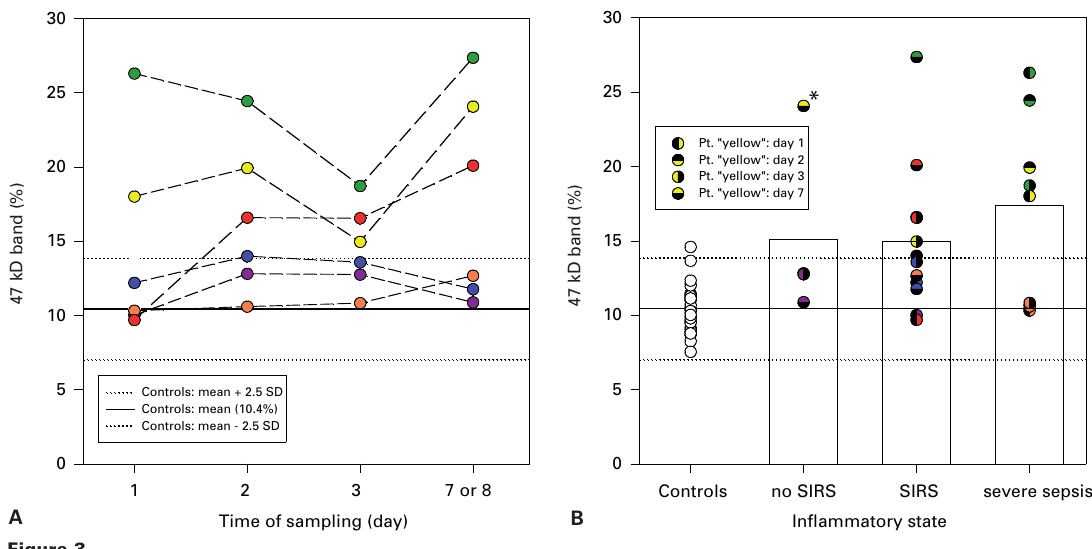
Contact system activation in sepsis vs. controls (analysis in %). Panels A and B are organised similarly to Figure 2. Panel A shows the analysis for 47kd light chain in % of total Hk. For this analysis the sum of all three detected bands (120kd + 61kd + 47kd) was considered to equal 100%. As well as illustrating increased CSA as a function of SiRS severity in sepsis patients, this figure shows that in healthy controls approximately 10% of Hk circulates in its cleaved form under basal conditions.This result suggests a basal turnover of Hk with a persistence of the 47kd fragment in the circulation. See Results section for comments regarding *.